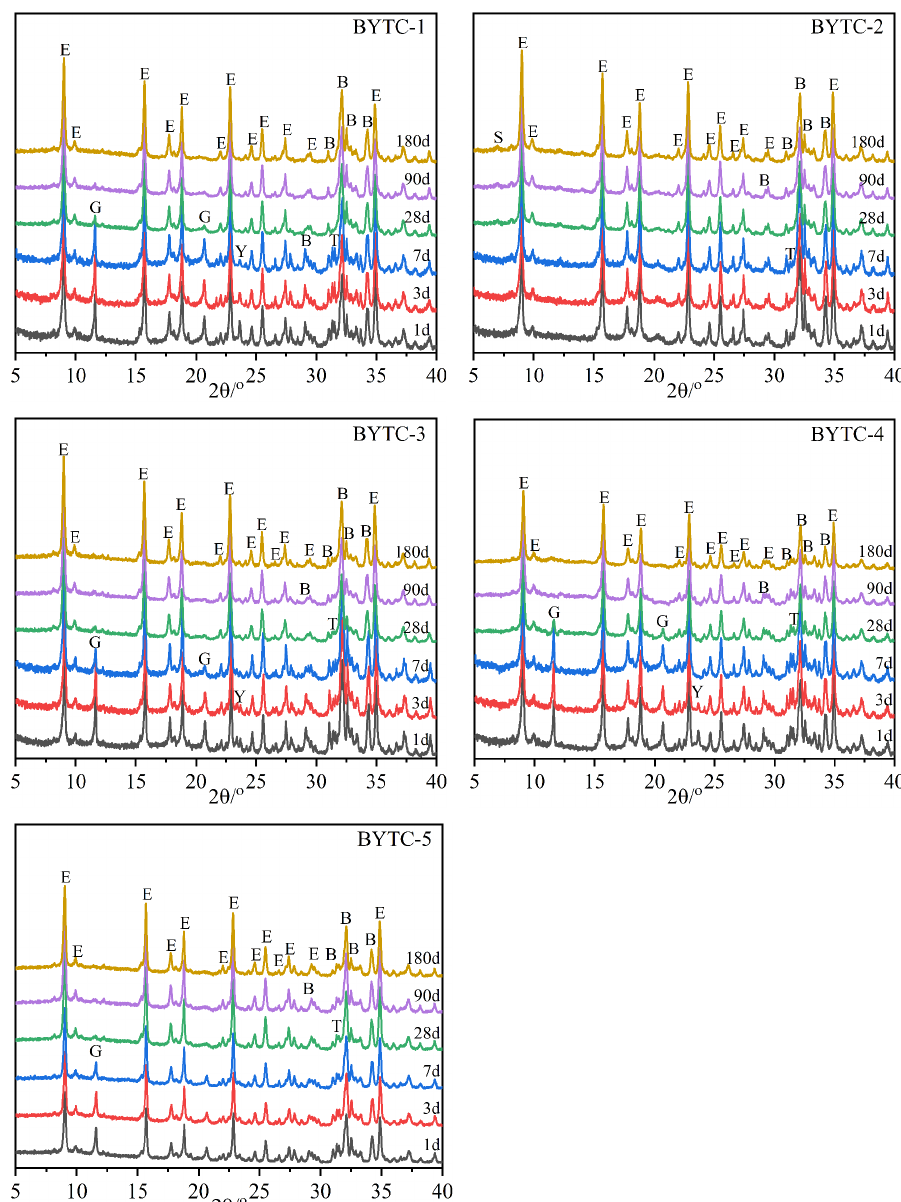
Figure 4. Diffractograms of hydrated pastes of BYT cement